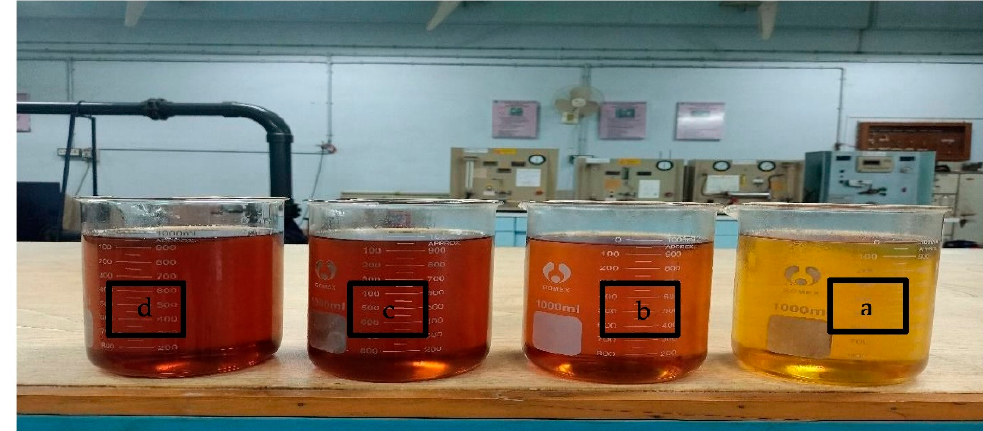
Figure 1. Physical postures of test fuels ( a ) Diesel ( b ) DF95-WCO5 ( c ) D65-WCO2-0Pe15, and ( d ) D60-WCO20-Pe20. Table 1 The characteristics of diesel, waste cooking oil and n-pentanol alcohol exploited in this experimental work. Table 1. Diesel, waste cooking oil and n-pentanol properties.